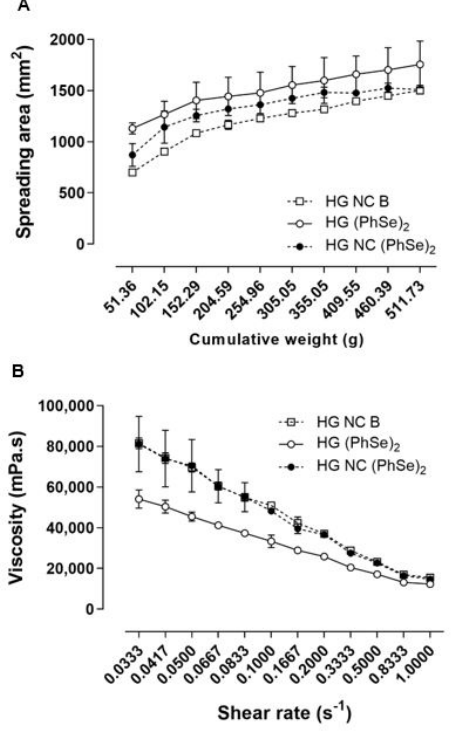
Figure 2. Graphical representation of the spreadability profile ( A ) and viscosity ( B ) of the hydrogels. Data are presented as mean and standard deviation. Statistical evaluations were performed by one-way ANOVA followed by Tukey ( p > 0.05). Table 2. Spreadability profile and rheological behavior concerning the regression coefficients (r 2 ) for mathematical modeling in shear rate-shear stress curves to models of Ostwald, Casson, and Bingham. Formulation